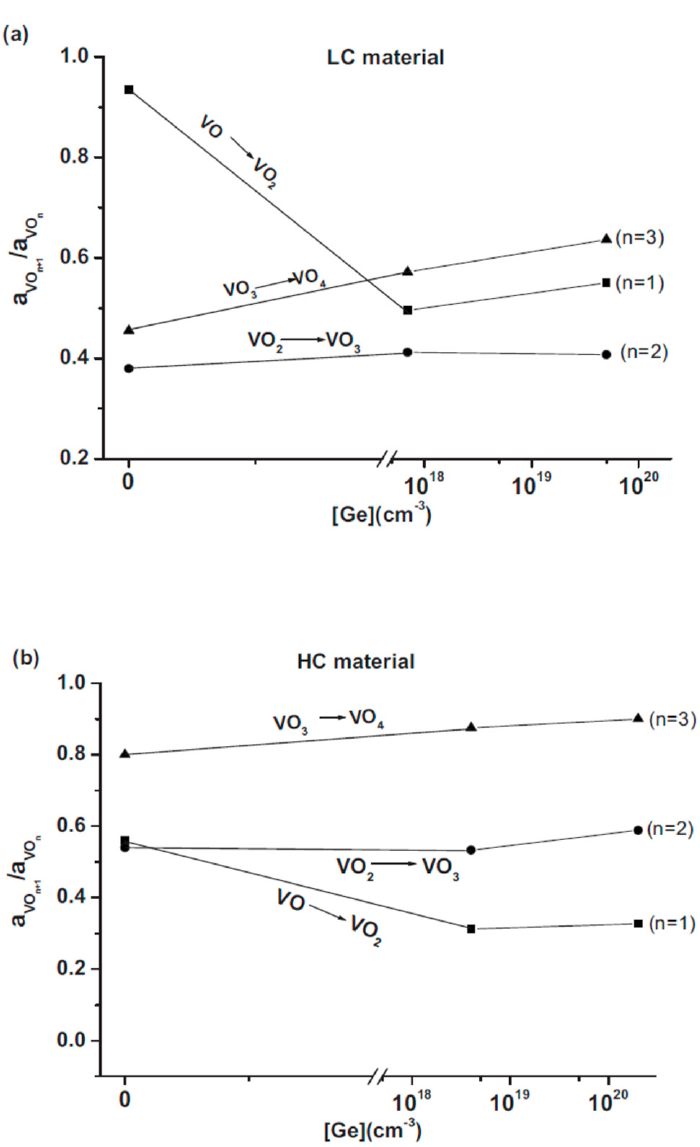
Figure 6. The conversion ratio (a VO2/ a VO ) of the VO to VO 2 defect as a function of the Ge dopant concentration in the Si samples [127]. ( a ) Low concentration (LC) and ( b ) high concentration (HC) material. Reproduced with permission from [127]. American Institute of Physics, 2011.